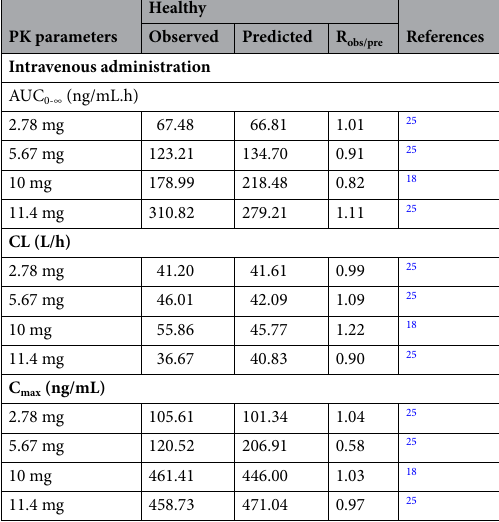
Table 4. The R obs/pre for PK parameters in healthy adults after iv administration of captopril.